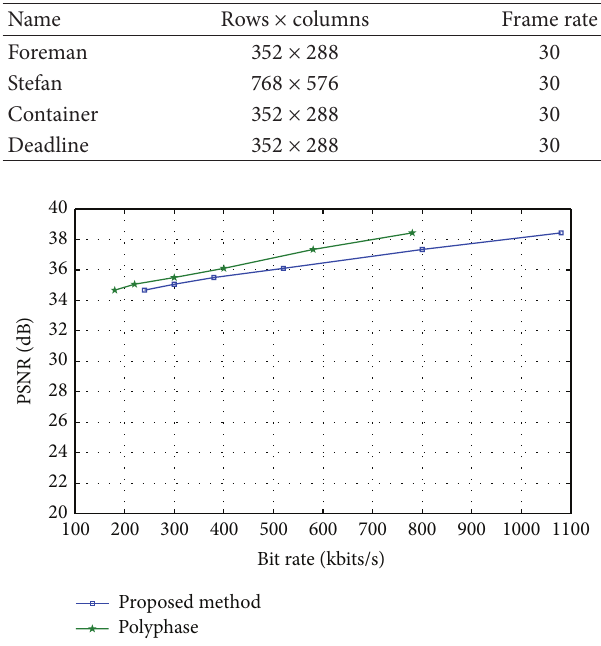
Figure 6: PSNR values at different bit-rates using polyphase and the proposed method (Foreman